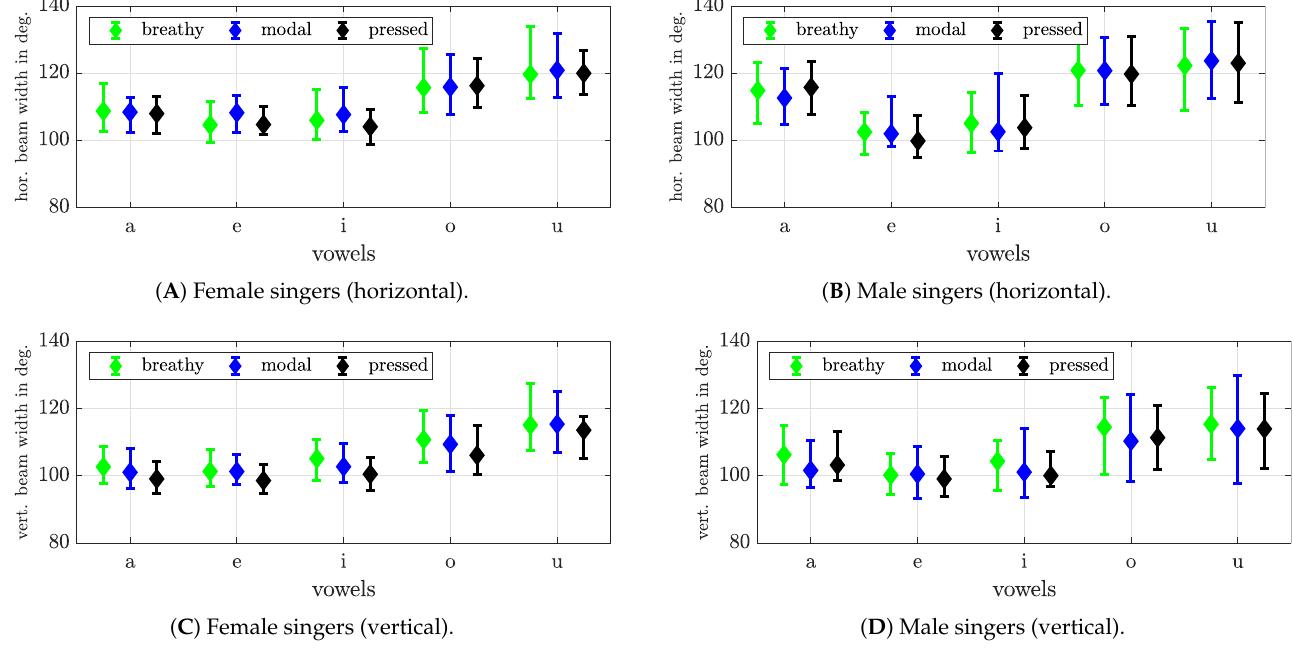
Figure 12. Medians and inter-quartile ranges for the beam width over all pitches in the horizontal ( A , B ) and vertical ( C , D ) plane for each vowel and phonation mode for the female and male